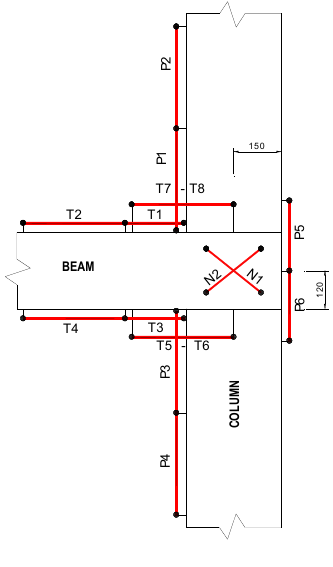
Figure 8. Layout of instruments.